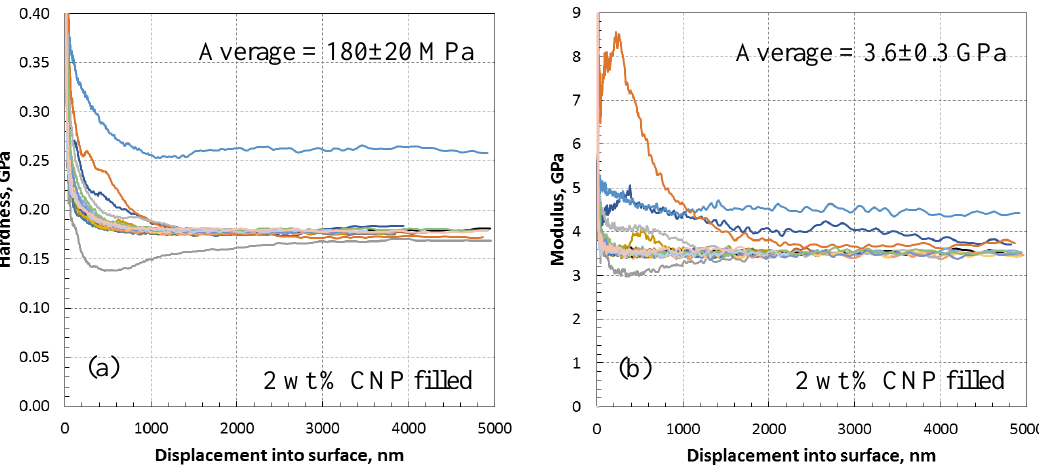
Figure 8. Nanoindentation data of 2 wt % CNP filled epoxy; ( a ) variation of hardness with depth showing non-steady hardness at or near CNPs with average hardness of 180 ± 20 MPa, ( b ) variation of modulus with depth showing non-steady modulus at or near CNPs (Figure 9) with average modulus of 3.6 ± 0.3 GPa.